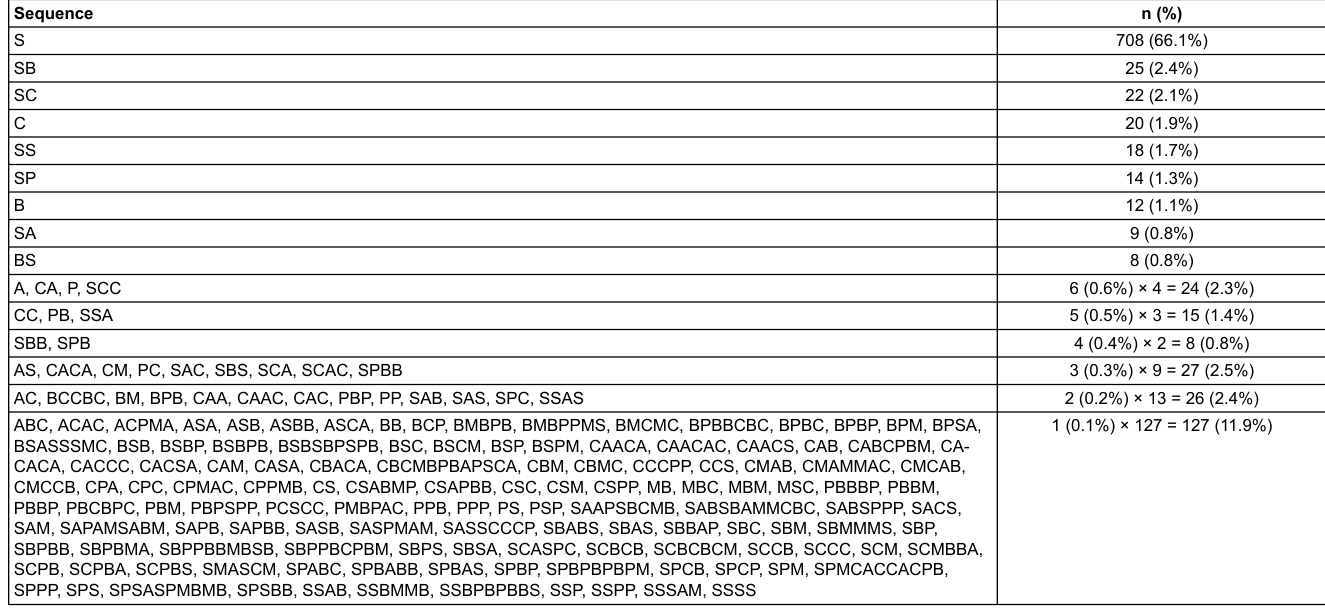
Table 3: All therapy sequences in the main analysis set (n = 1063). Sequence